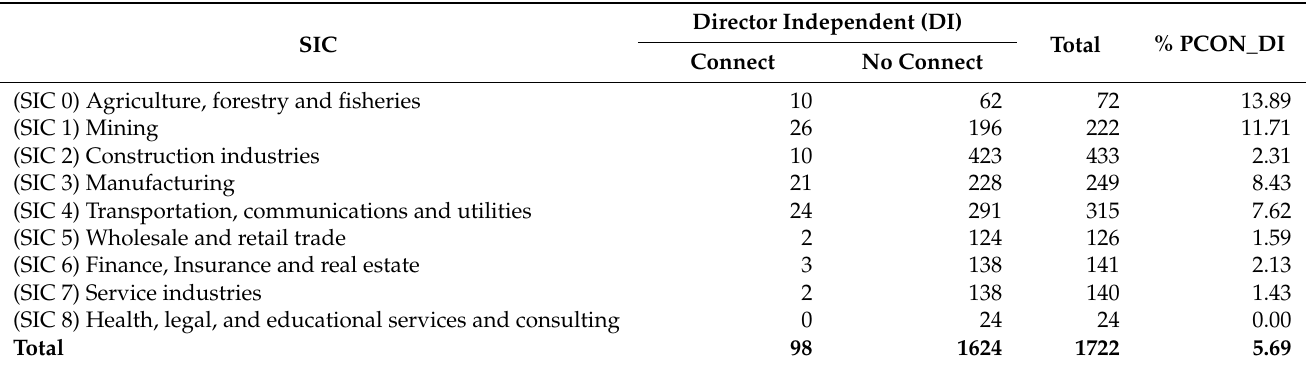
Table 3. Distribution of Politically Connected Independent Directors by Standard Industry Classifica- tion